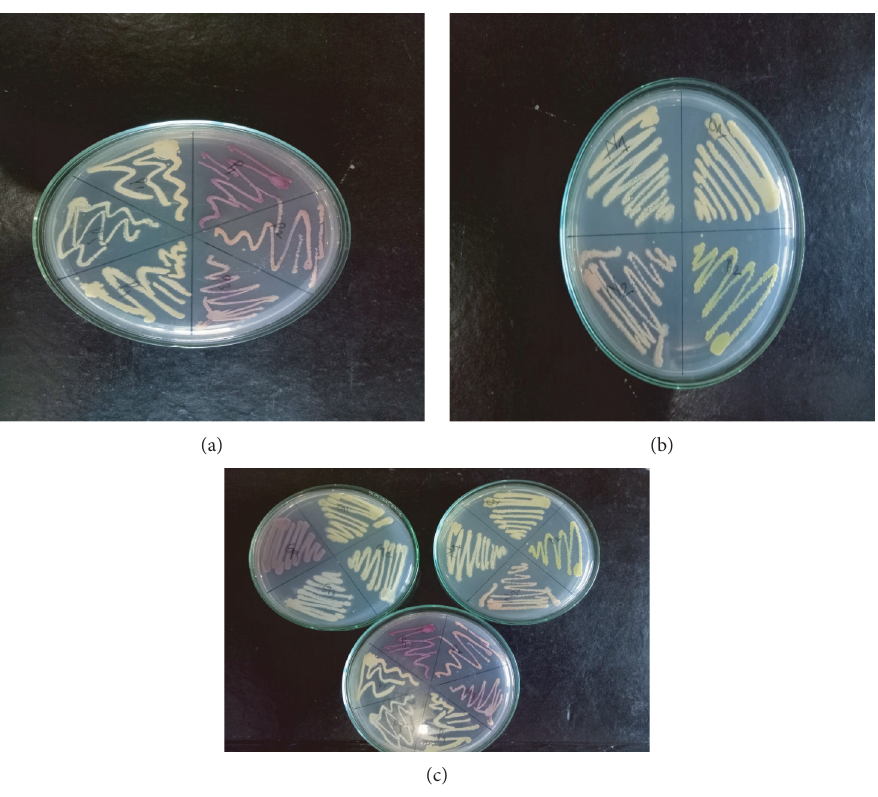
Figure 4: Subculture colony of actinomycetes. A Starch Casein Agar (SCA) plate showing the growth of actinomycetes with different colors and textures which can be utilized as macroscopic distinguishing characteristics (a), (b), and (c).